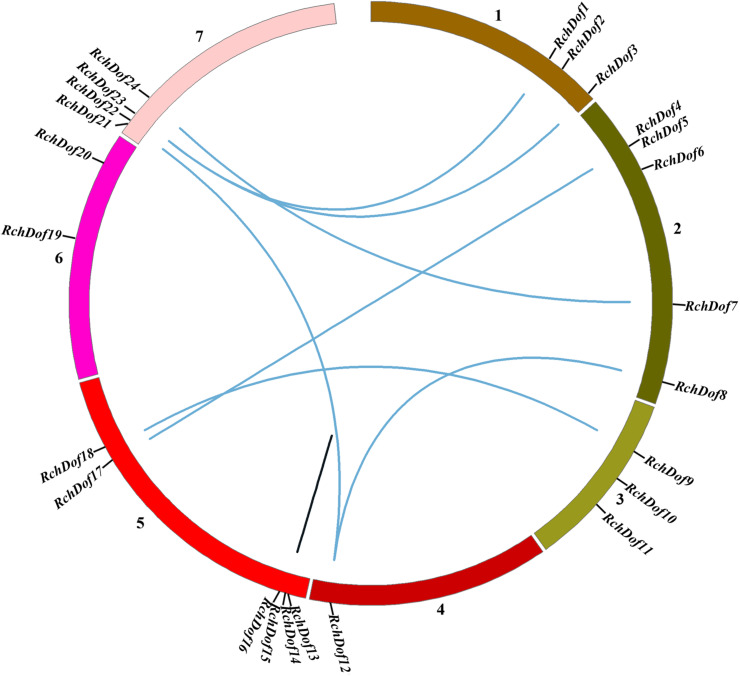
Chromosome distribution and synteny analysis of rose Dof genes. Chromosomes 1–7 are shown with different colors. The approximate location of each RchDof gene is marked with a short black line. Blue lines indicate segmentally duplicated RchDof genes, and black lines in the circle indicate tandemly duplicated genes.